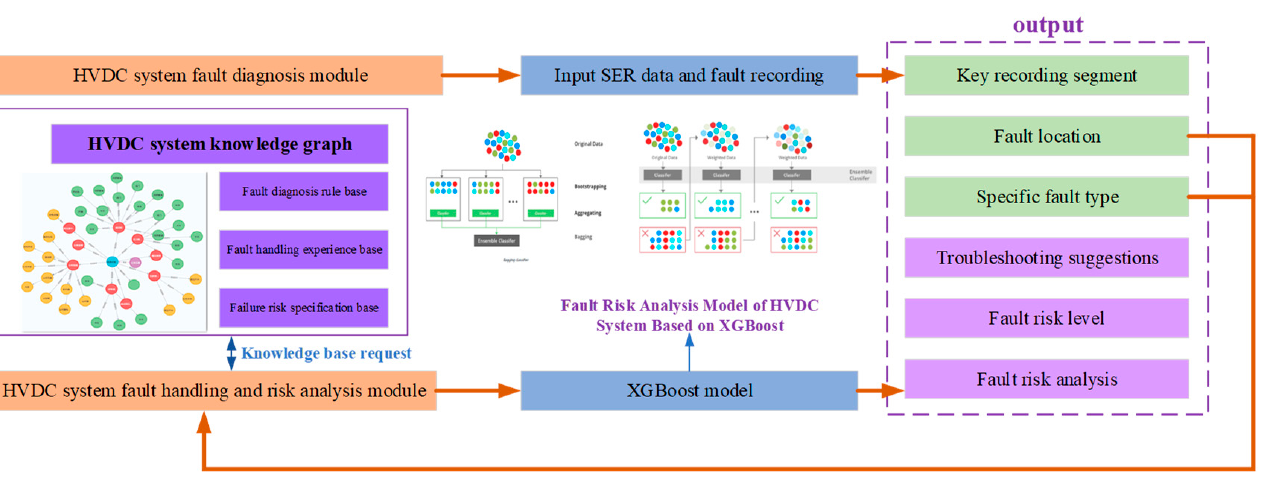
Figure 1. Flow chart of HVDC system abnormal signal identification and auxiliary decision making based on state information.